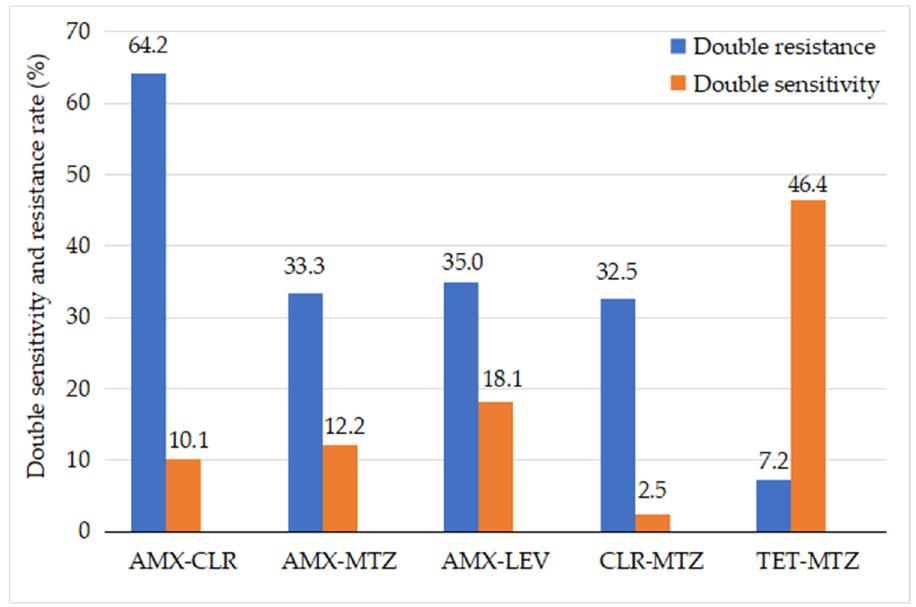
Figure 2. The frequency of double susceptibility and resistance to antibiotics of H. pylori in pediatric patients. CLR, clarithromycin; AMX, amoxicillin; MTZ, metronidazole; LEV, levofloxacin; TET, tetracycline.